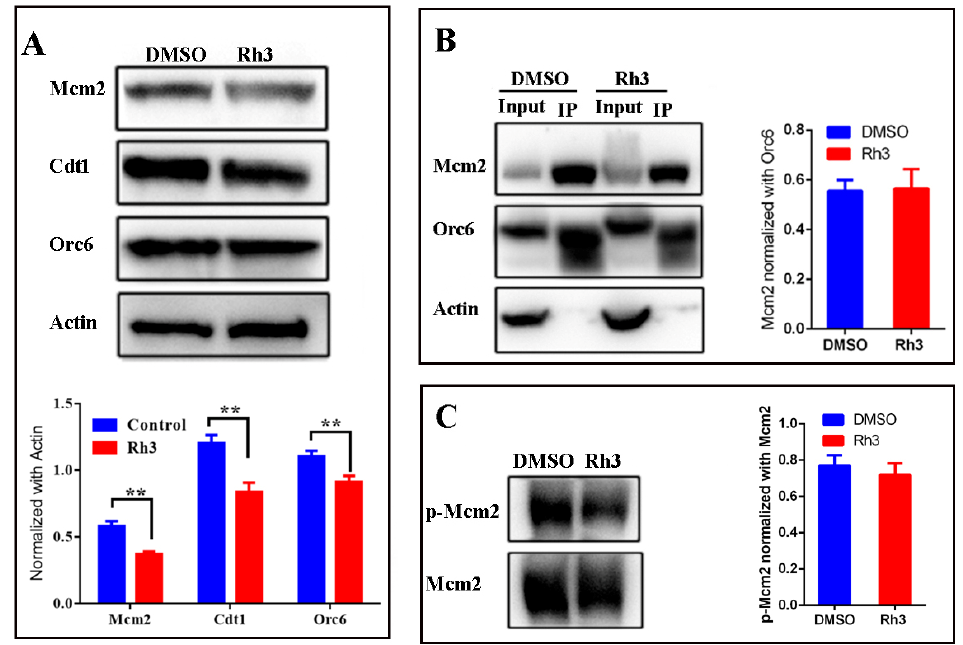
Figure 3. Effect of Rh3 on the expression of DNA replication initiation proteins. ( A ): Expression of Mcm2, Cdt1, and Orc6 in HCT116 cells (Western blotting with actin as the loading control). ( B ): Effect of Rh3 on the interaction between Orc6 and Mcm2 (Co-IP assay). ( C ): Expression of Mcm2 and phosphorylated Mcm2 (western blotting). Groups were compared using a two-tailed Student’s t -test. ** p < 0.01.